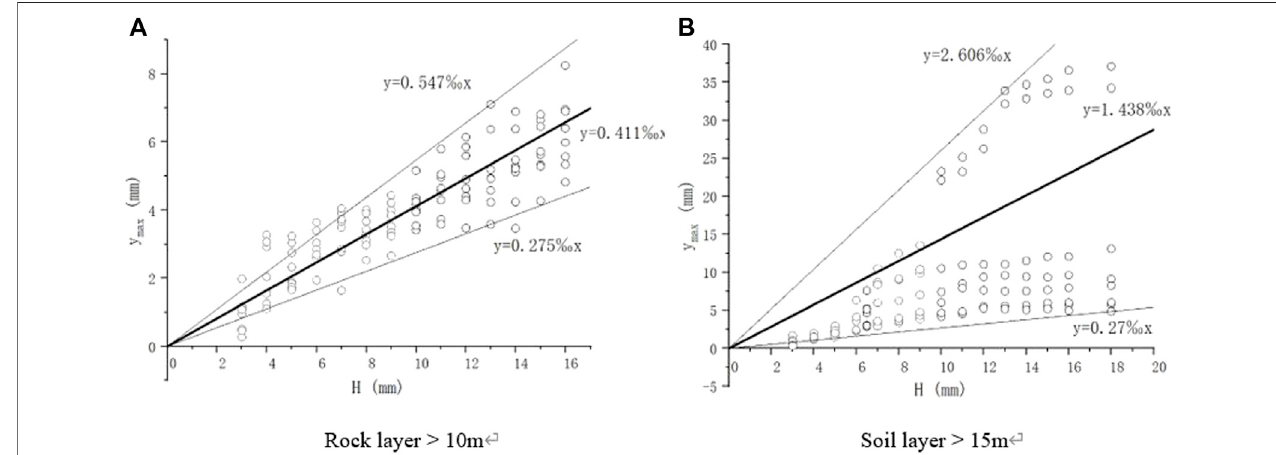
FIGURE 6 | y max − H relationship: ( A) when rock layer > 10 m; (B) when soil layer > 15 m